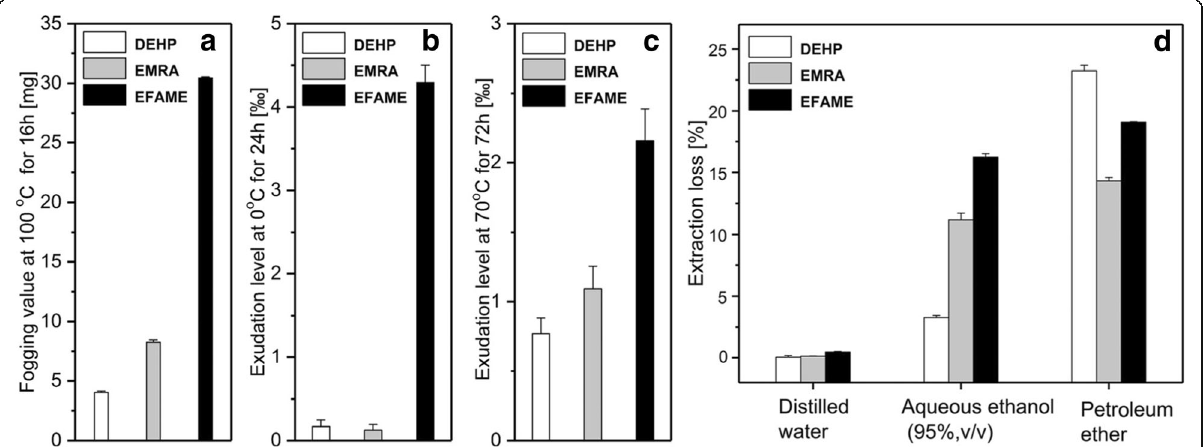
Fig. 4 a Fogging value, and plasticizer exudation level at b 0 °C for 24 h and c 70 °C for 72 h of the plasticized PVC membranes. The extraction loss of plasticizers from the PVC membranes in different liquid media was shown in